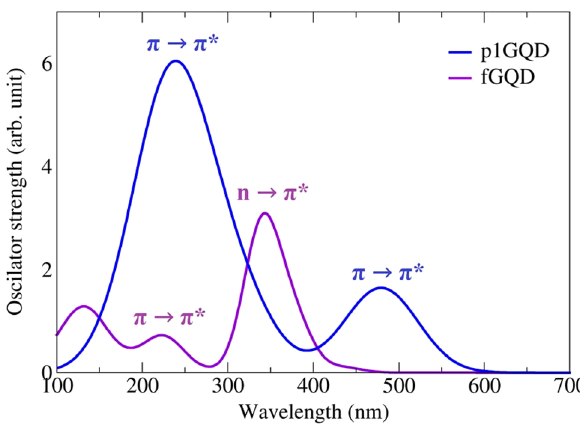
Figure 7. Simulation result of the excitation spectra of p1GQD (blue line) and fGQD (purple line).